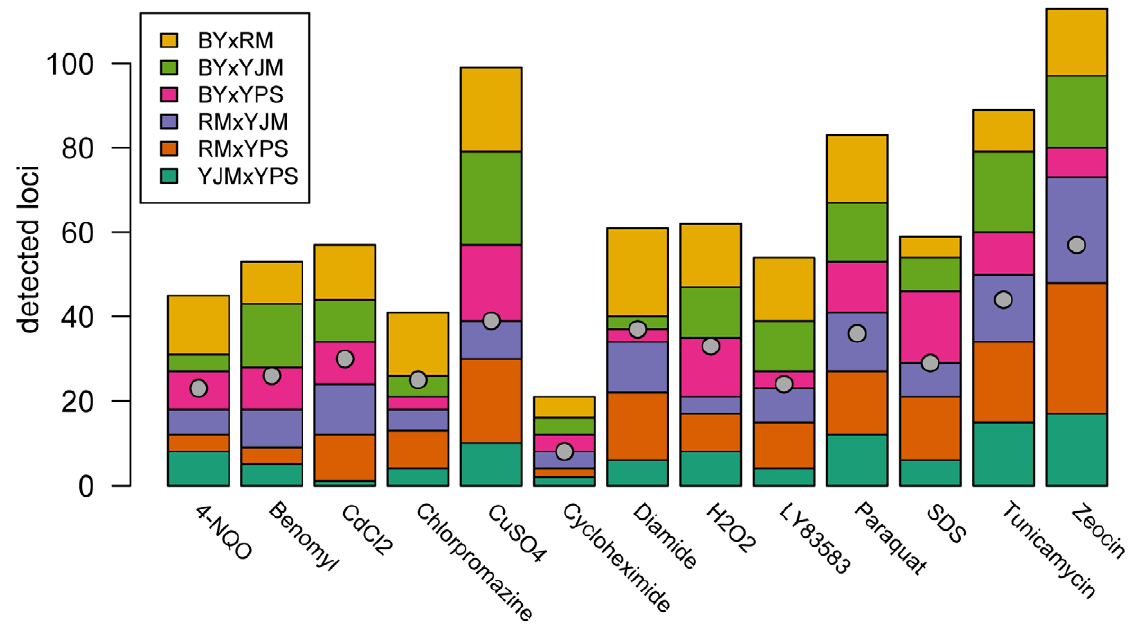
Figure 1. Numbers of detected peaks and distinct loci. The stacked bar plots show the number of peaks detected for each trait using X-QTL selections in each cross. The first parent listed in each cross was MAT a and the second parent was MAT a . The grey dots indicate the number of distinct loci detected in a condition after peak grouping.